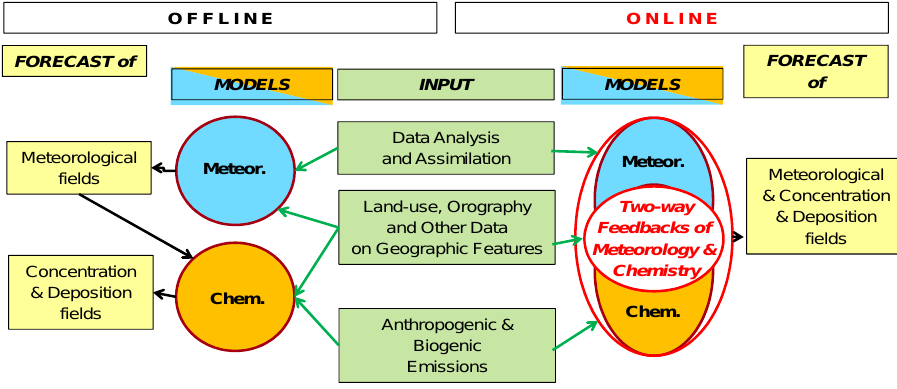
Fig. 1. Schematic diagram of (left) offline and (right) online coupled meteorology and chemistry modelling approaches for air quality and meteorology simulation and